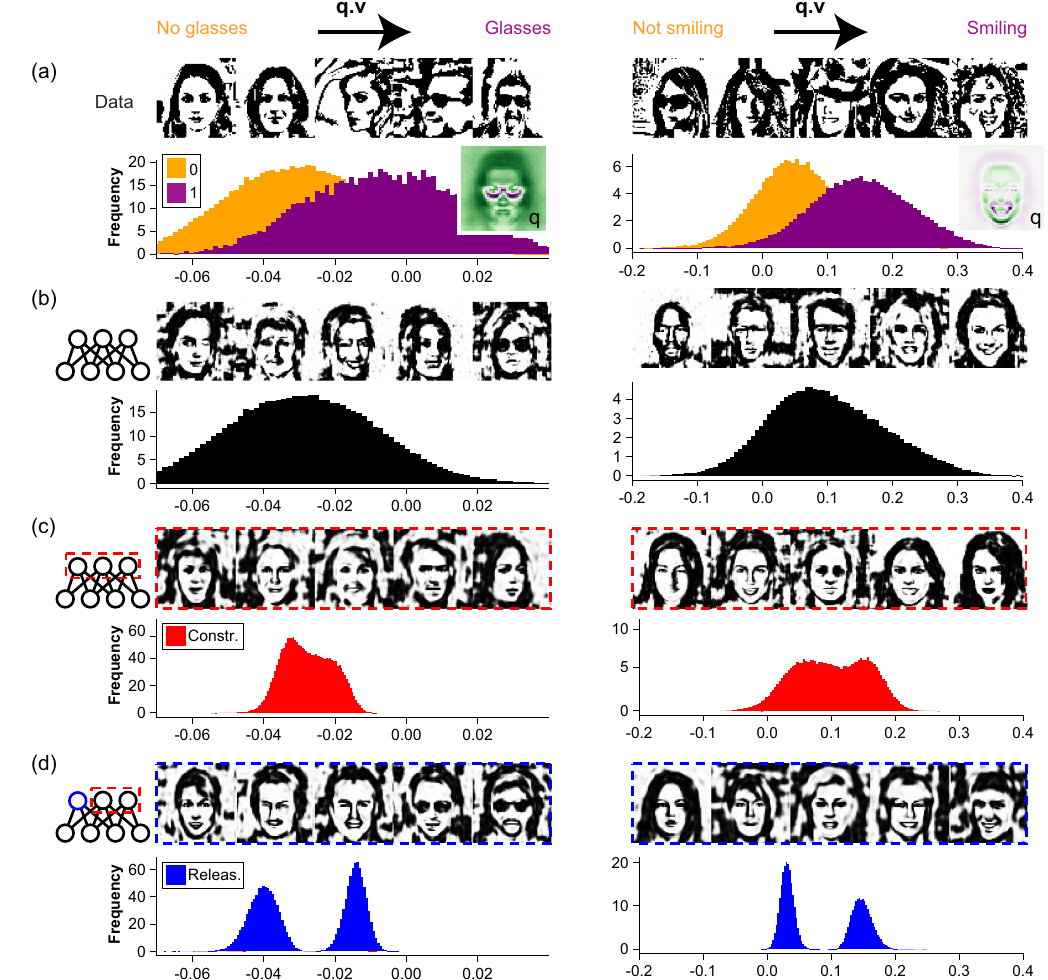
FIG. 5. Application to the CelebA dataset. Left: label corresponds to the presence or absence of eyeglasses. Right: label corresponds to smiling or not smiling. (a) Selected images from the data arranged by the value of their projection along the vector q defined in Eq. (7). Below, the histogram of these projections is computed for all images in the data. The inset shows a heat map of the vector q . (b) Samples generated by an unconstrained RBM and histogram of their projections on vector q . (c) Samples generated by a RBM, all the hidden units of which are subject to the constraint in Eq. (6) (dashed red). The histogram (red) of projections on q concentrates on intermediate values. (d) Samples generated by a RBM trained under constraint (6) acting on all but one released hidden unit (dashed blue) and histogram of projections along q (blue). Details about the RBMs ’ architecture and training can be found in the Supplemental Material [26] Appendix A